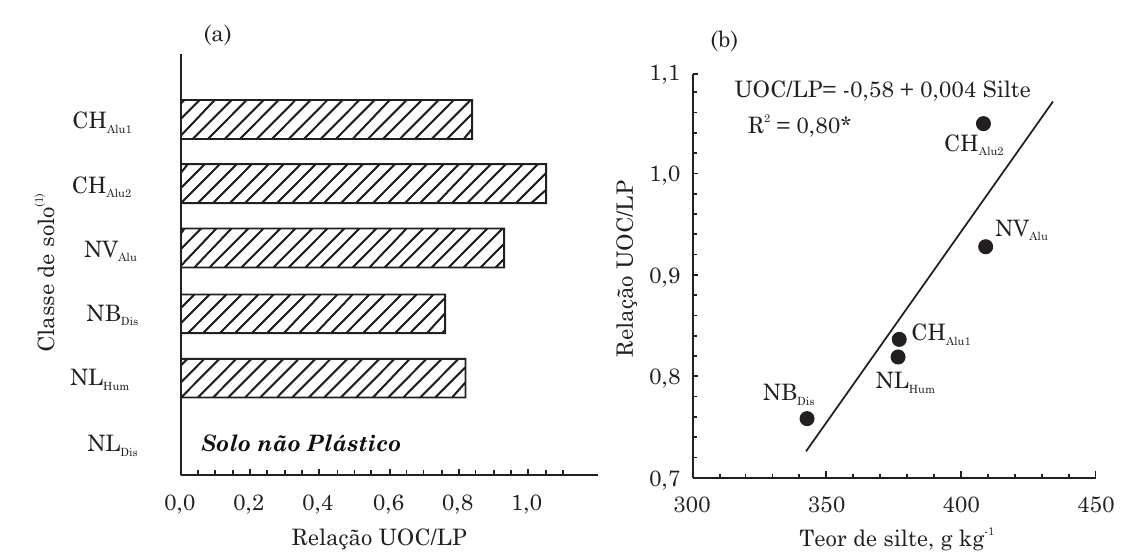
Figura 6. Relação entre umidade ótima de compactação e limite de plasticidade (UOC/LP) (a) e relação entre UOC/LP e o teor de silte (b) do horizonte A de seis solos do Planalto Sul Catarinense. (1)